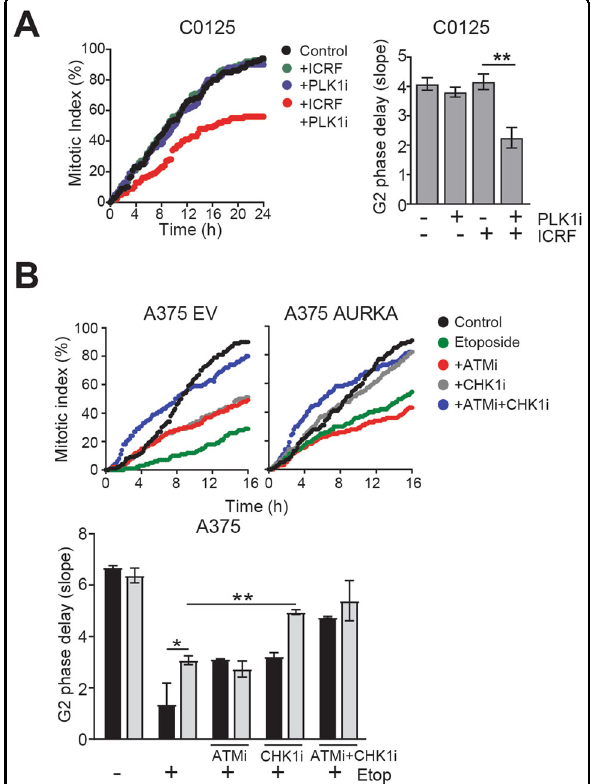
Fig. 3 AURKA over-expression selectively overcomes ATM- but not ATR-dependent G2 phase checkpoint arrest. A G2 phase delay assessed by time lase imaging of PPP6C mutant C0125 cells treated with ICRF193 or 100 nM PLK1 inhibitor (PLK1i) BI2536 alone, or in combination. Bars represent means (±SD) of three independent experiments. ** p < 0.01. B Representative line graphs demonstrate the rate of cells entering into the mitosis. A375 EV and AURKA overexpressing cells were treated with 4 μ M of etoposide or 5 μ M of ATM inhibitor (ATMi) KU55933 or 0.5 μ M of CHK1 inhibitor (CHK1i) GNE323 alone, or in combination. Statistical analysis was performed using one-way ANOVA. Bars represent means (±SD); * p < 0.05.